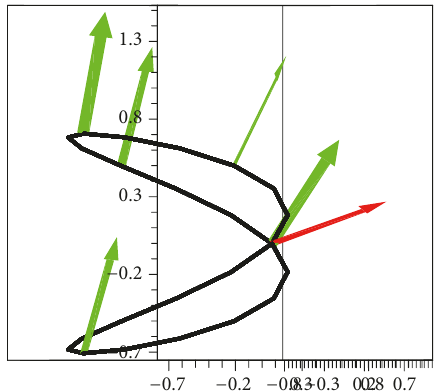
Figure 6: Red vector is 𝛾 󸀠 (0) = {2, 0,1,0} , and green vectors are magnetic fields 𝑉 = (√42/21){√2/2,1,2√2, 1}